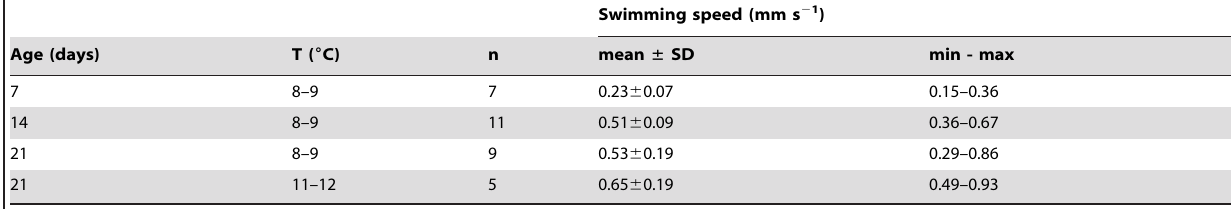
Table 1. Lophelia pertusa larval swimming